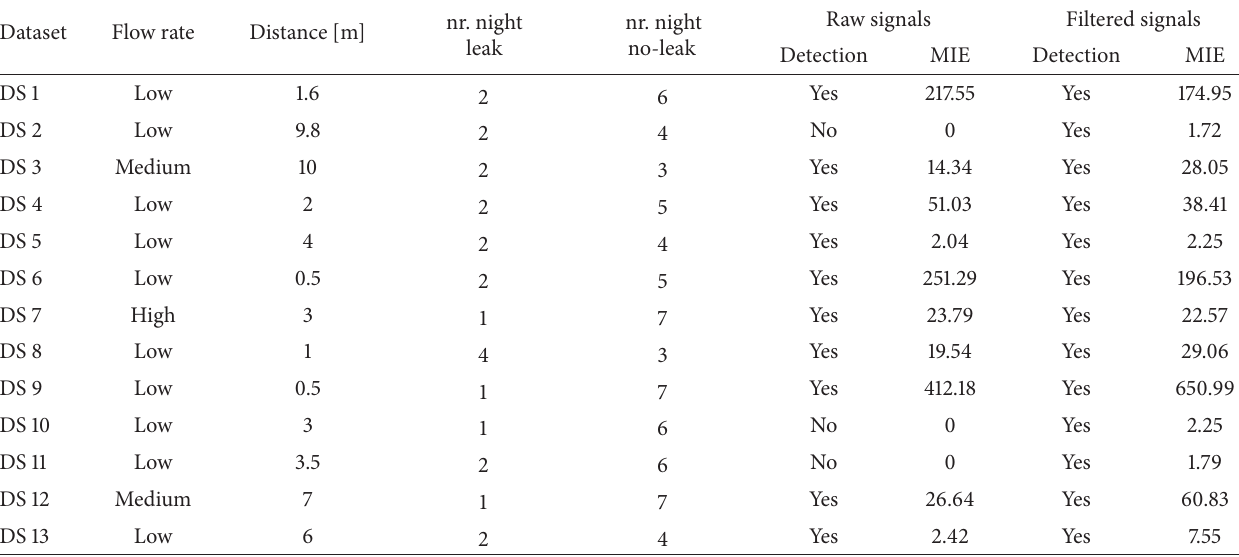
Table 1: Characteristics of the monitored leaks and related measurements and results of the algorithm applied to raw signals and band-pass filtered